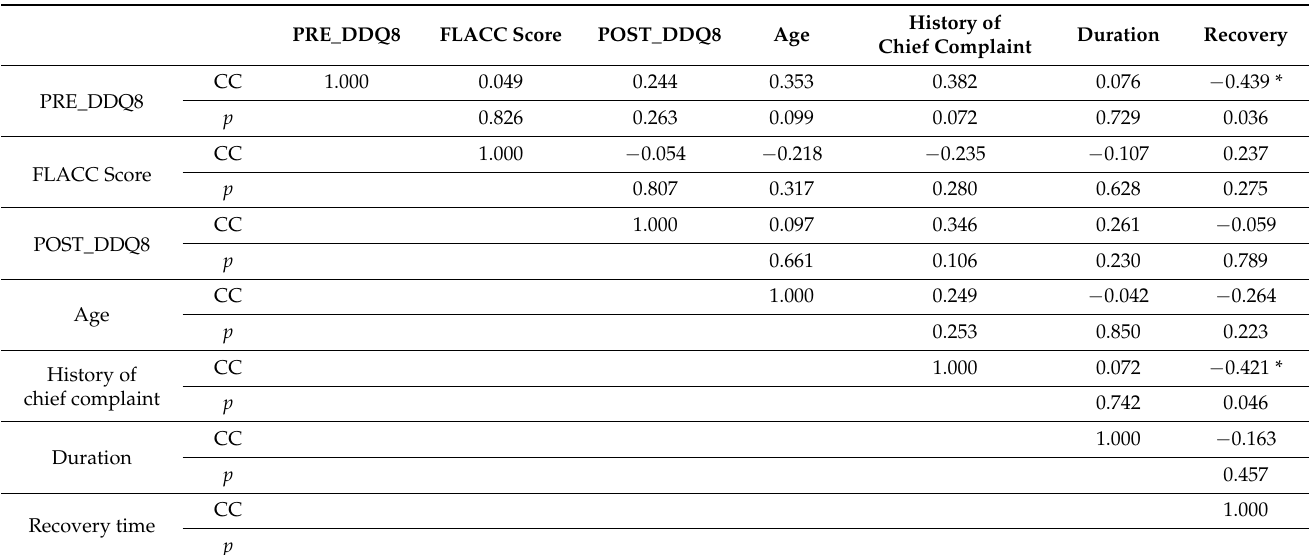
Table 8. Correlations between different